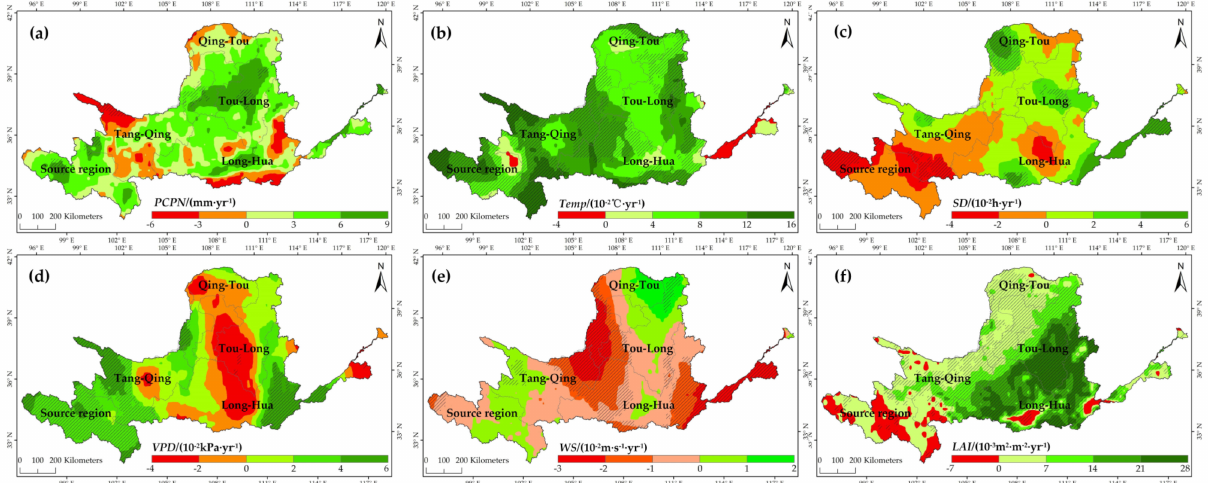
Figure 6. Spatial distributions of the trends of the climatic and vegetation factors: ( a ) Precipitation (PCPN), ( b ) temperature (Temp), ( c ) sunshine duration (SD), ( d ) vapor pressure deficit (VPD), ( e ) wind speed (WS), and ( f ) leaf area index (LAI). Regions that lie within the pattern of diagonal lines represent areas with significant trend ( α <